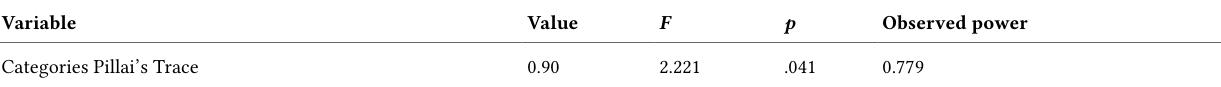
Multivariate Analysis of Variance (MANOVA) Between Categories of Exercise Dependence and Areas of Body Esteem for Male Gym-Goers Variable Value F p Observed power Categories Pillai’s Trace